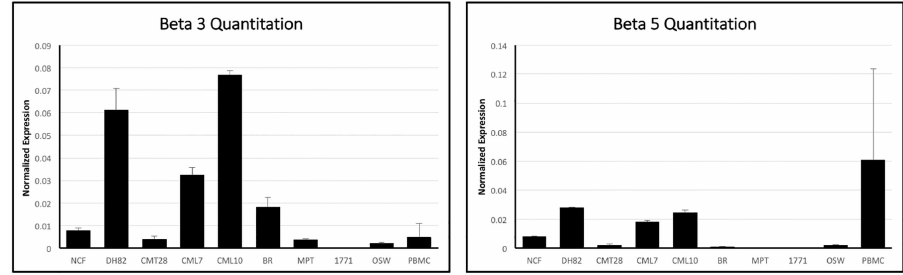
Fig 6. Quantitative RT-PCR analysis of beta-3 and beta-5 membrane integrin mRNA in canine non- cancerous (NCF and PBMC), non-hematopoietic origin cancer (CMT28, CML7, and CML10), and hematopoietic origin cancer (DH82, 17–71, OSW, MPT-1, and BR) cells using specific primers. beta-3 and beta-5 mRNA expressionlevels were normalized to levels of control β -actinmRNA expressionand quantified using the Δ Ct